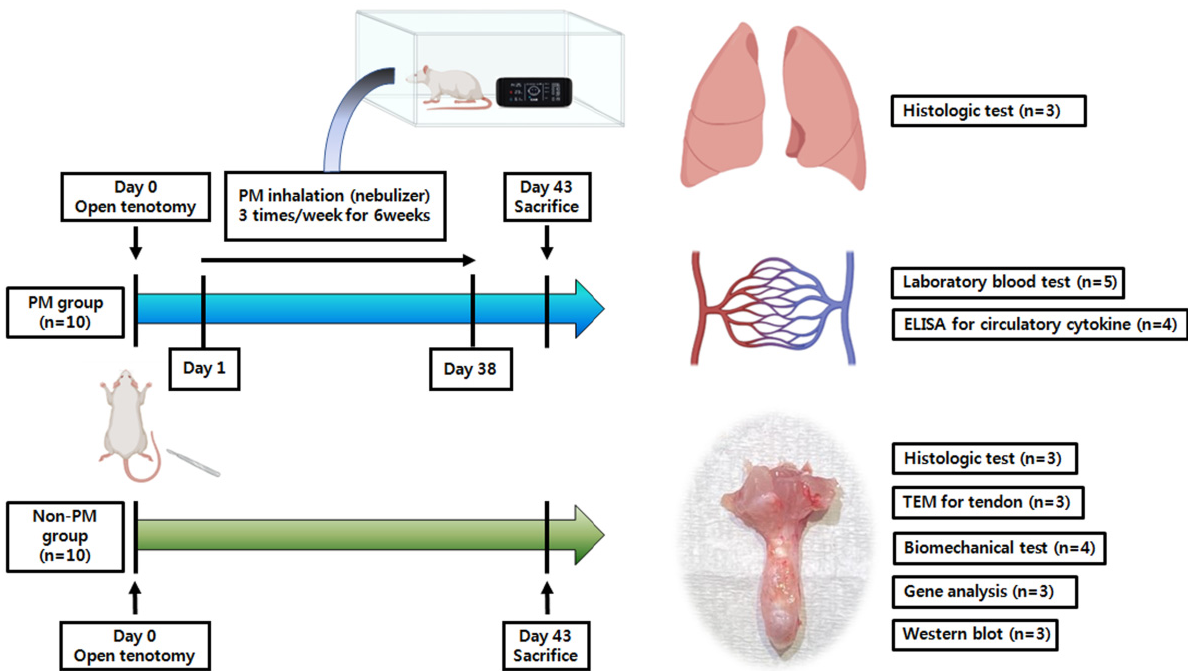
Figure 7. Overview of the experimental protocol. ELISA, enzyme-linked immunosorbent assay.